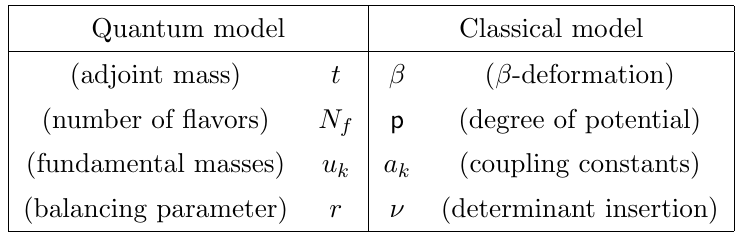
Table 1 . Matching of parameters between quantum and classical models. While the integer parameters N f and p can be straightforwardly identi(cid:12)ed, for the other parameters the identi(cid:12)cation is slightly less obvious. The (cid:12) -deformation is obtained by identifying the adjoint mass as t = q (cid:12) while (cid:23) can be related to the e(cid:11)ective FI parameter through the parameter r . Similarly, the coupling constants a k are given by non-trivial functions of the masses u k